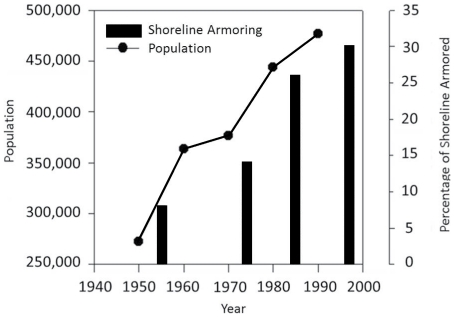
Population Growth and Shoreline Armoring in Mobile Bay, Alabama.Adapted with permission from Douglass and Pickel 1999, this figure depicts the rate and extent of shoreline armoring in Mobile Bay. The vertical bars in the main graph show the proportion of armoring while the line depicts the increasing population levels for Mobile and Baldwin Counties.